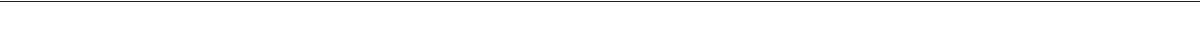
Fig. 5 Correlation of iPE and prediction error potential (PE-LFP). a Population grand-averages for different response measures, computed for each lemniscal station (in columns, represented in fi rst row highlighted in green). The second row shows the average LFP across all tested tones and single neurons from each station for different conditions. The third row displays the average fi ring rate pro fi les for each station as normalized spike-density functions. The fourth row contains the prediction error potentials (PE-LFP, black trace), which is the difference wave of the deviant and the control LFP. Along PE-LFP, the time course of the average iPE is plotted in orange (mean ± SEM, asterisks indicating signi fi cant iPE for the corresponding time window; Wilcoxon signed- rank test for 12 comparisons, corrected for FDR = 0.1). Next row shows an instantaneous p value (white trace) of the corresponding PE-LFP (paired t test against equal means, corrected for FDR = 0.1, critical threshold for signi fi cance set at 0.05 represented as a horizontal bar). Thick black bars of the grey panel mark time intervals for which the average PE-LFP is signi fi cant. Note that only AC L shows a signi fi cant prediction error signal. b Same as in a but computed for each non-lemniscal station (highlighted in purple in the fi rst row). Note in the last row signi fi cant PE-LFPs appear in all three stations (IC NL , MGB NL and AC NL ), and prominently in AC NL . Note also how highest iPE values are concurrent with the strongest PE-LFPs in time and location (auditory cortex, both AC L and AC NL